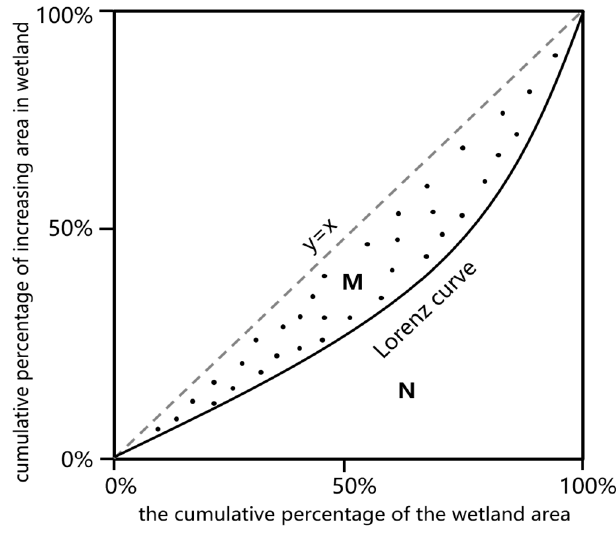
Figure 1. The Lorenz curve.